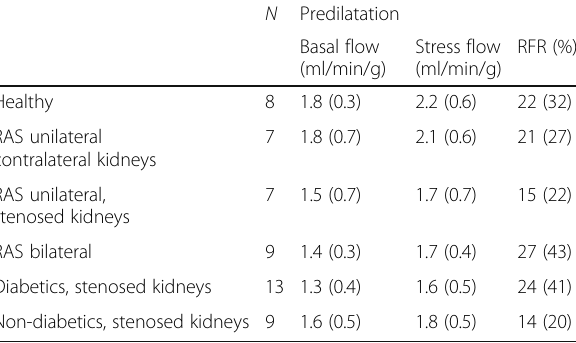
Table 2 RFR and flow values in the healthy and RAS